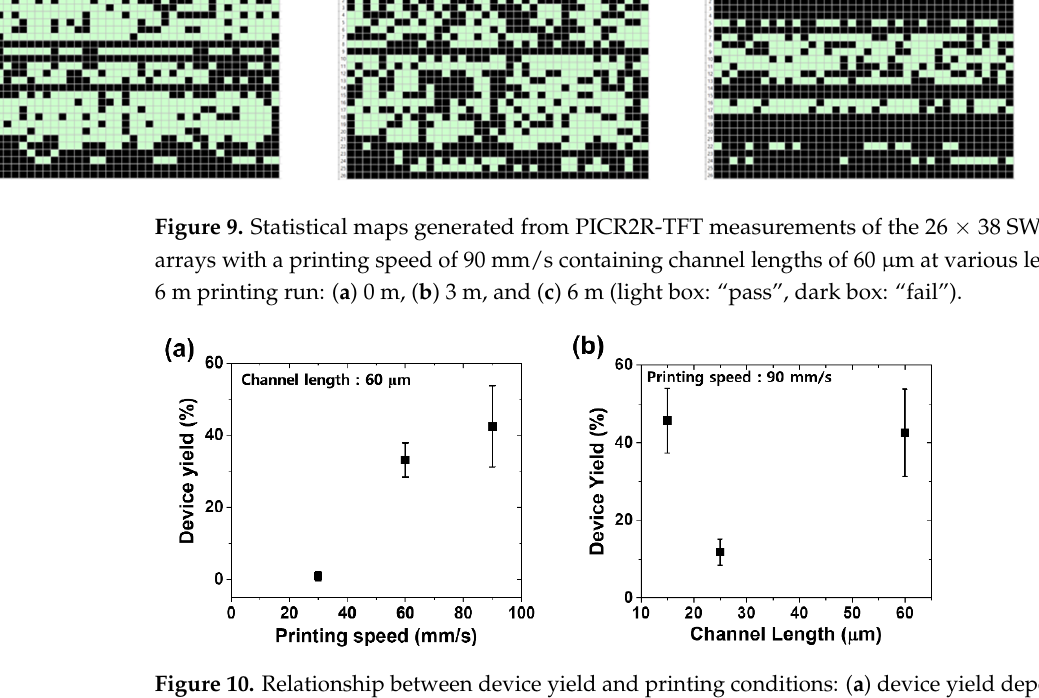
Figure 10. Relationship between device yield and printing conditions: ( a ) device yield depending on different printing speeds and ( b ) device yield depending on channel lengths.